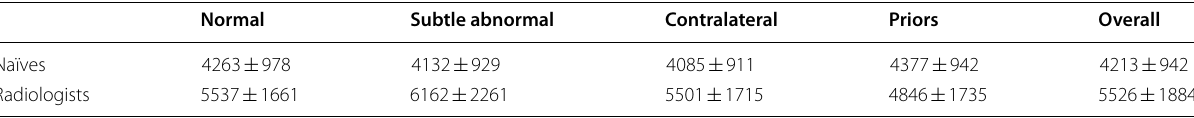
23) and radiologists ( n 11) during no time limit conditions, per image = =